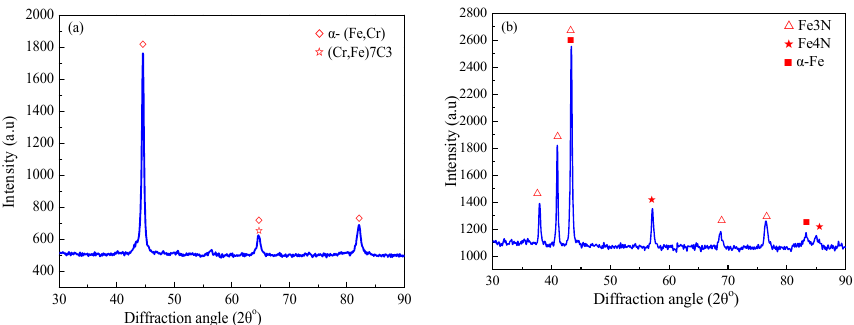
Figure 2. XRD patterns of ( a ) cladding layer, and ( b ) nitriding layer. For the nitriding layer, the main peak of the diffraction curve was Fe 3 N, and a dense formed a nitrogen-containing solid solution. With the increase in nitrogen concentration, Fe 3 N and Fe 4 N were precipitated at a certain depth from the surface layer.